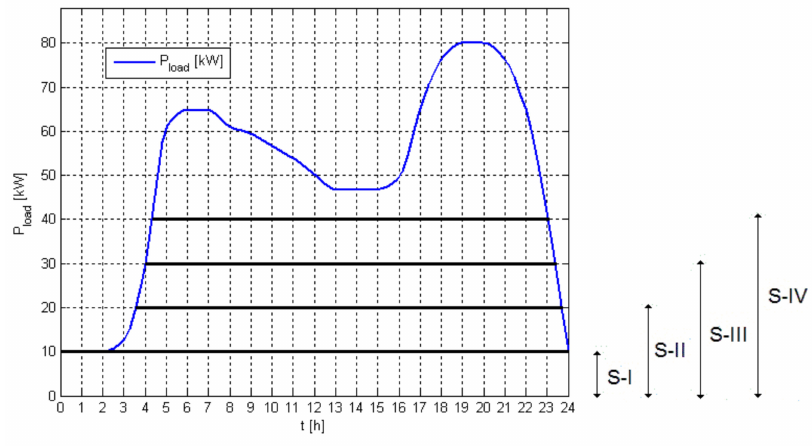
Figure 8. Energy profile of the consumer (S-I, S-II, S-III, S-IV—work scenarios)—own